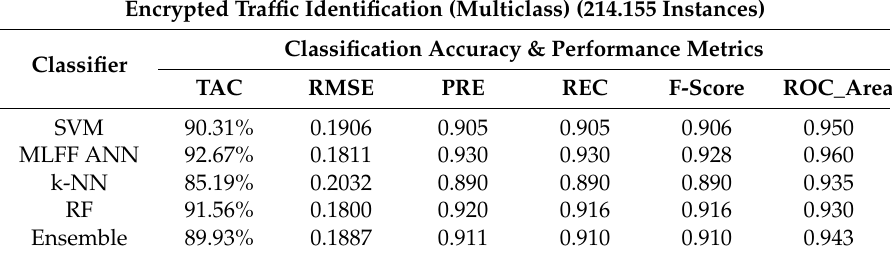
Table 4. Comparison between algorithms.